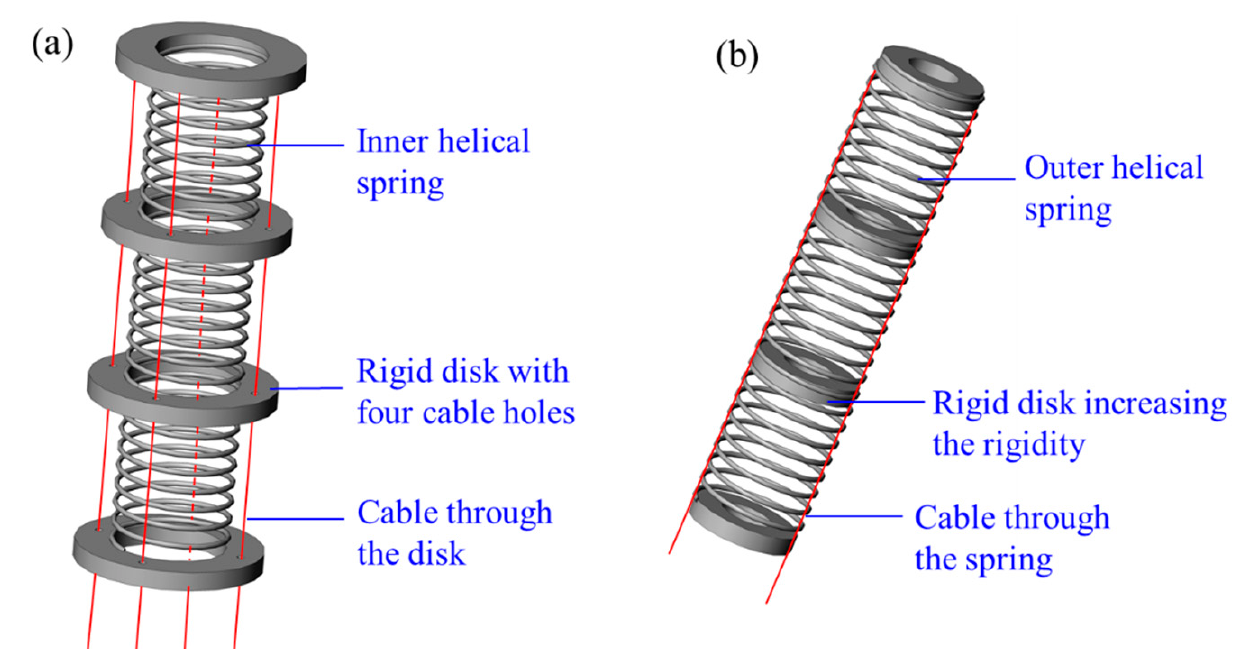
Figure 7. Spring CCRs formed with: ( a ) An inner helical spring [79,89] and ( b ) an outer helical spring [85].